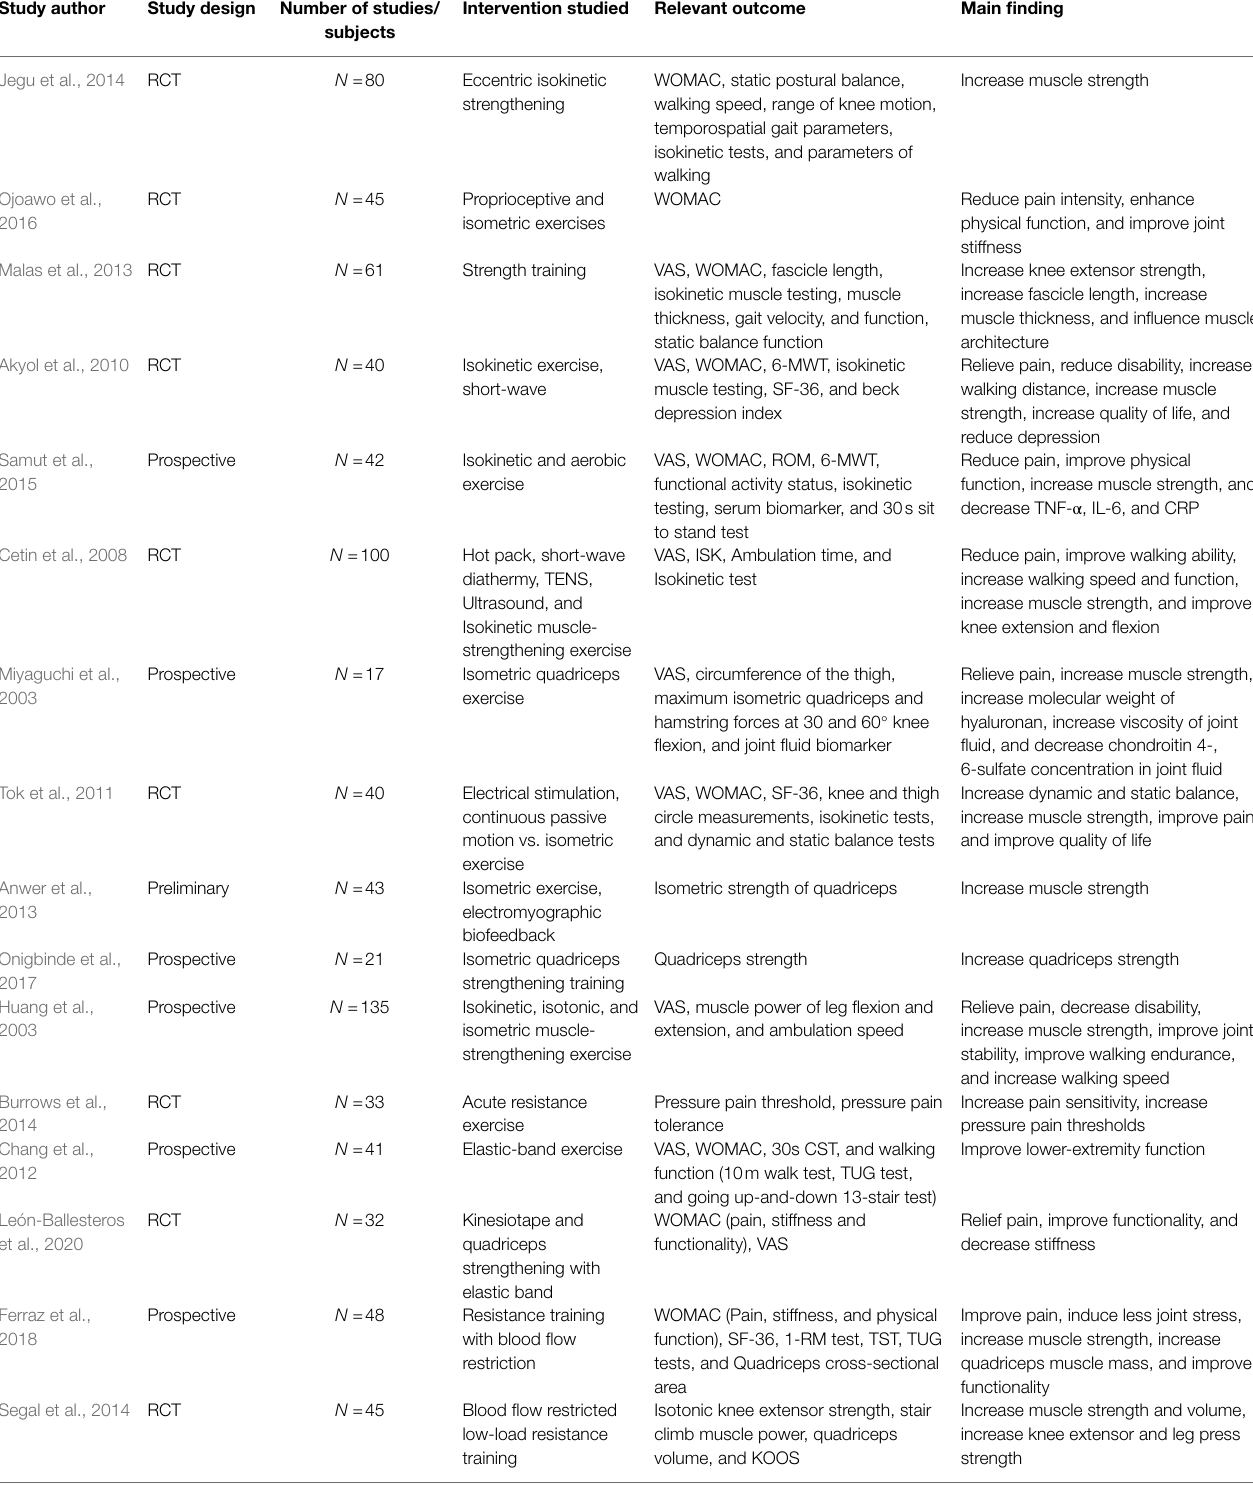
TABLE 1 | Summary of strength training included in this